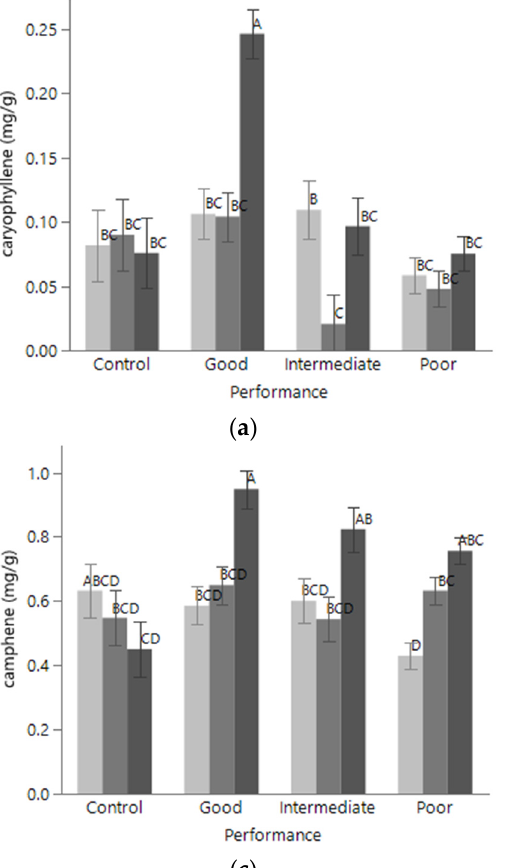
7 of 11 Table 1. p values for all 10 quantifiable HIPV compounds. Degrees of freedom (df) for each com- pound are as follows: Performance Group df = 3, Sampling Period df = 2, and Performance Group × Sampling Period df = 6. Asterisk (*) indicates significant p values ( α = 0.05). Performance